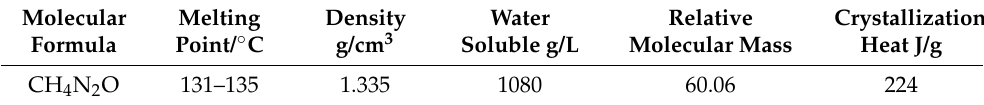
Table 2. Physical properties of urea.